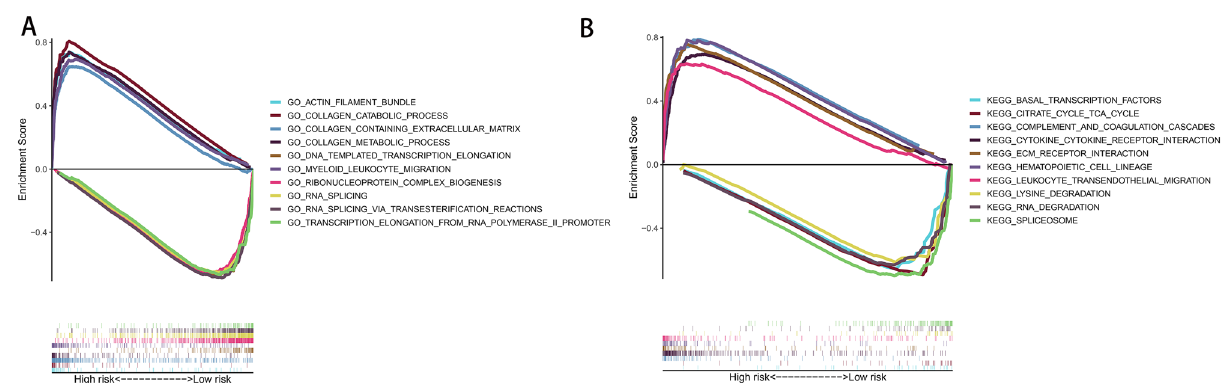
Figure 7. GSEA analysis between the high-risk and low-risk group in the TCGA whole set. ( A ) Signature was associated with gender, N, cancer status and status. ( A ) GO term enrichment analysis. ( C ) KEGG